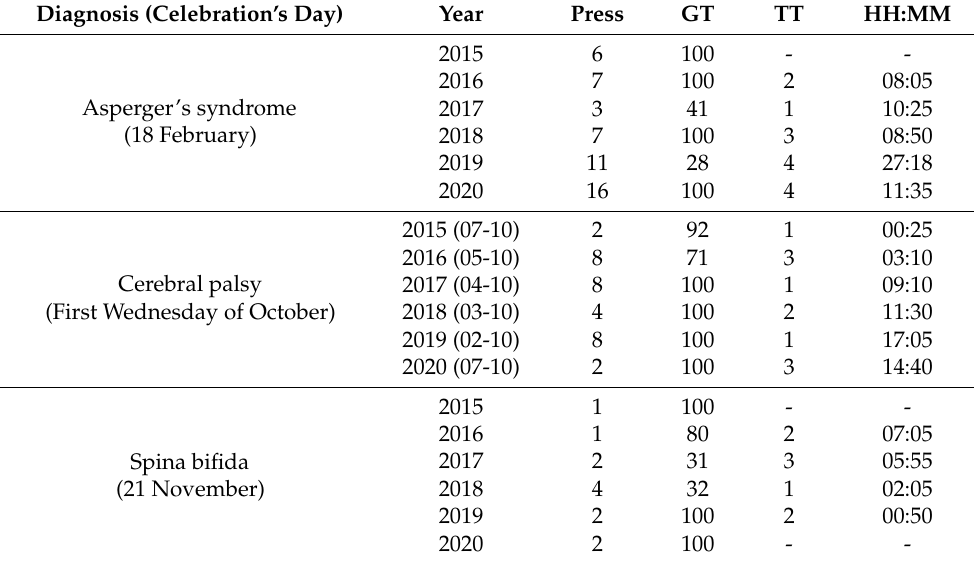
Table 5. Campaigns with medium impact 1